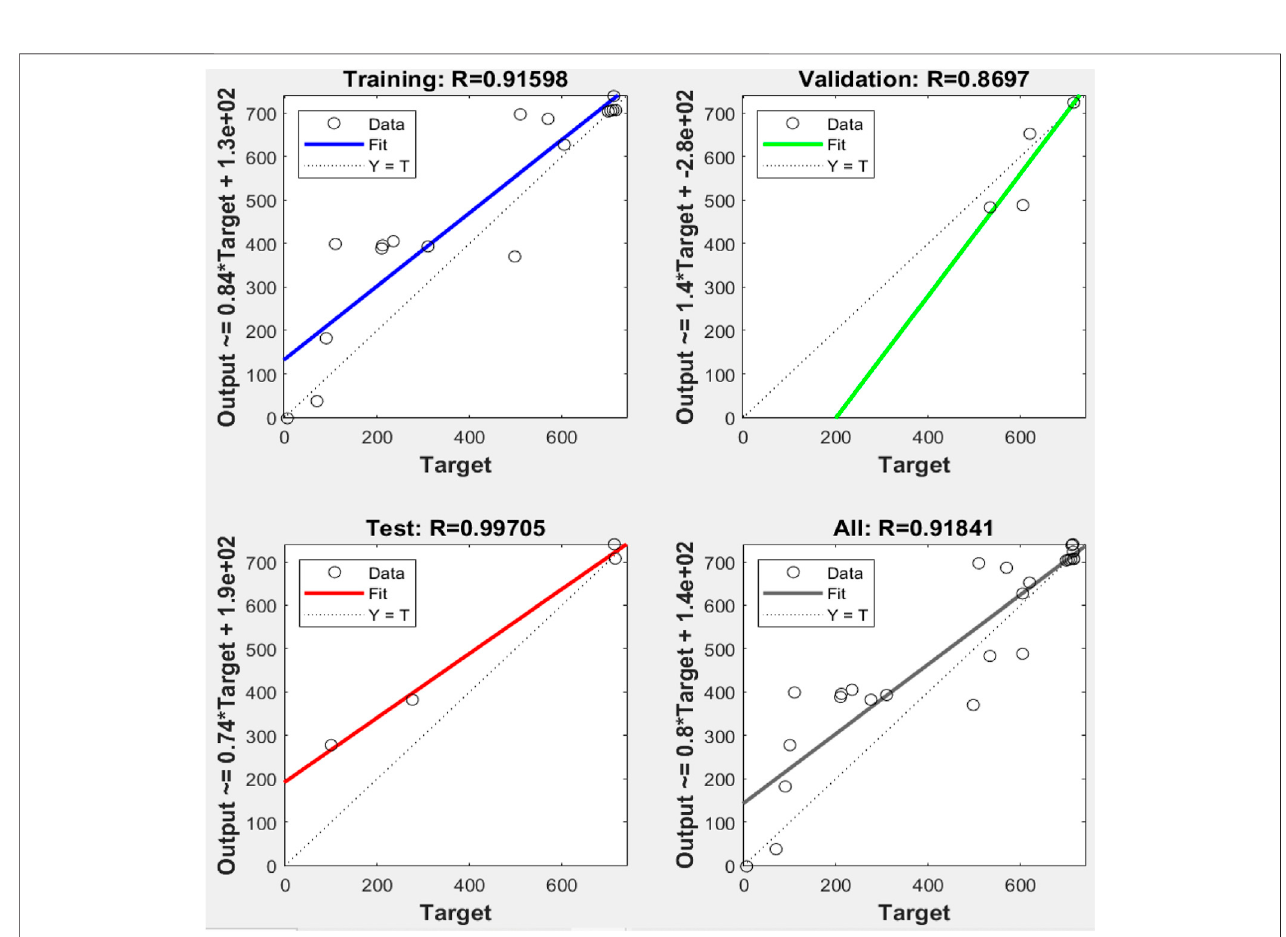
FIGURE 8 | Comparison between linear regression and ANN model results plotted and the observed values for training, validation, and testing.